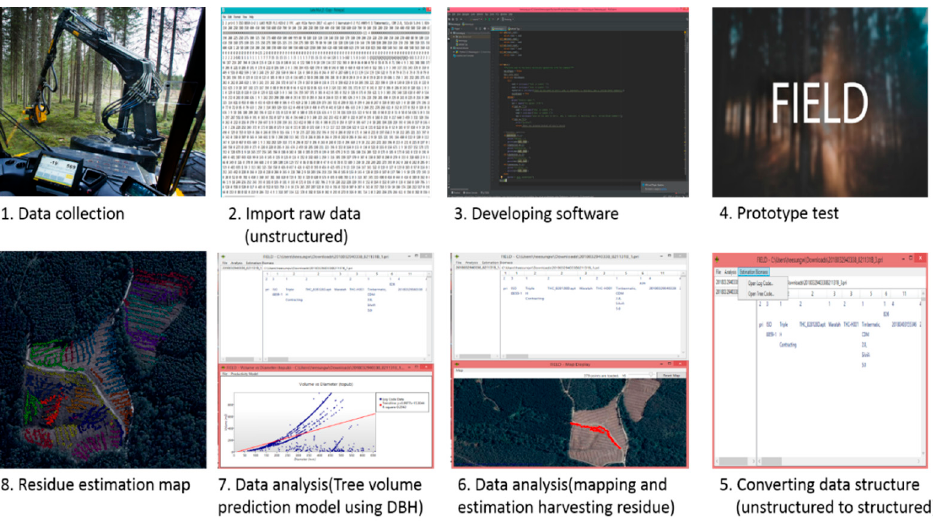
Figure 4. Diagram with the overall research process. Table 1. Description of the forest inventory data in pri file (identification number of variables and